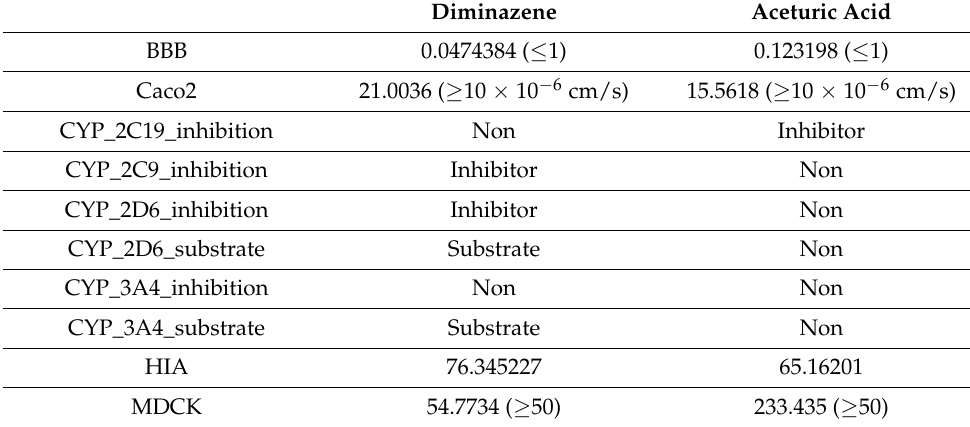
Table 7. The ADME results of diminazene and aceturic acid, according to